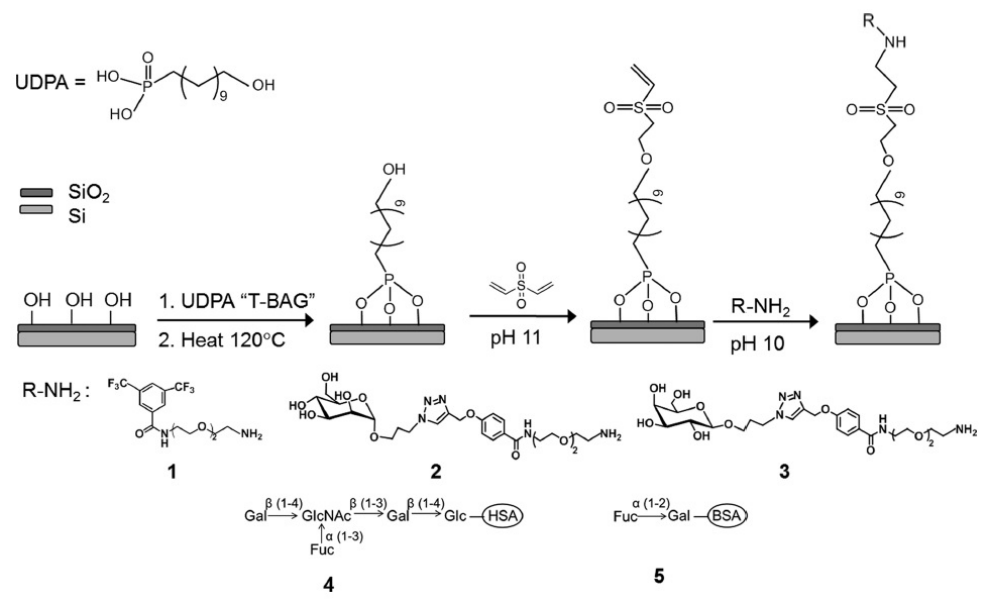
Figure 7. Schematic illustration of silicon substrate functionalization using 11-Hydroxyundecyl phosphonic acid (UDPA) and divinyl sulfone (DVS)-linking chemistry. Capture agents: hexafluorobenzamide ( 1 ), mannosyl amino OEG ( 2 ), galactosyl amino OEG ( 3 ), LNFPIII-HSA ( 4 ), and H2-BSA ( 5 ). Abbreviations of carbohydrate residues in 4 and 5: Gal, galactose; Fuc, fucose; GlcNAc, N-acetylglucosamine; Glc, glucose. (Reproduced from reference